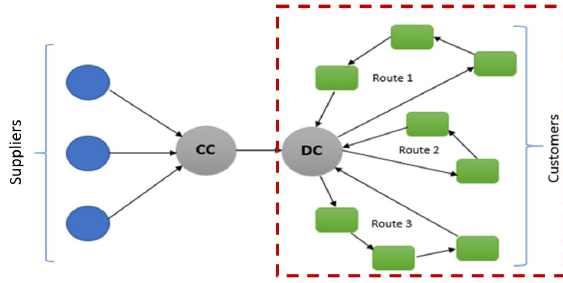
Fig. 4. Focus area on the distribution process starting from DC to the